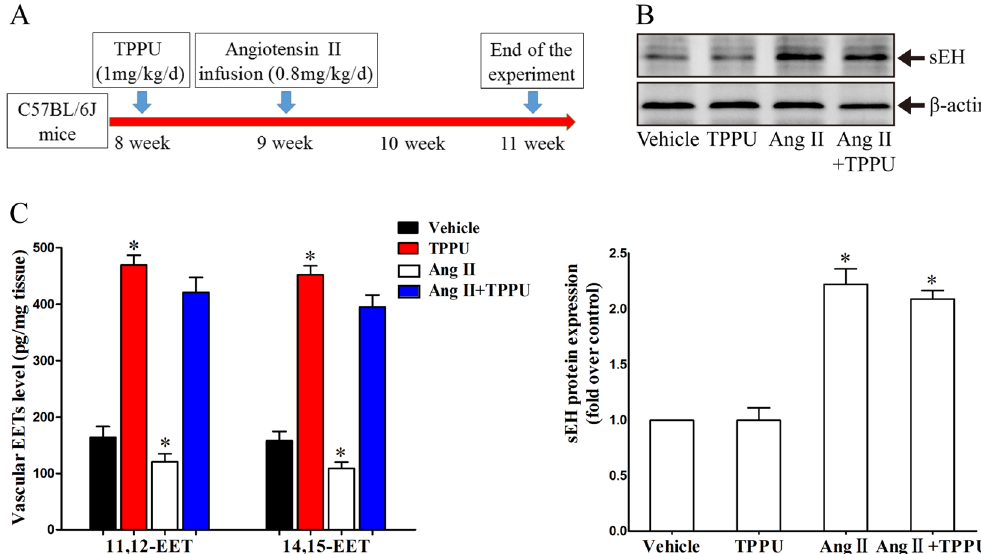
Figure 1. sEH was involved in adventitial remodeling process. ( A ) Schematic of animal model. ( B ) Representative immunoblots and quantitation of sEH protein expression in aortas of Ang II-infused mice. ( C ) Vascular 11,12-EET and 14,15-EET levels measured by LC/MS. Data were expressed as Mean ± SEM, n = 8 mice for each group. * p < 0.05 vs. Vehicle. Full-length blots/gels are presented in Supplementary